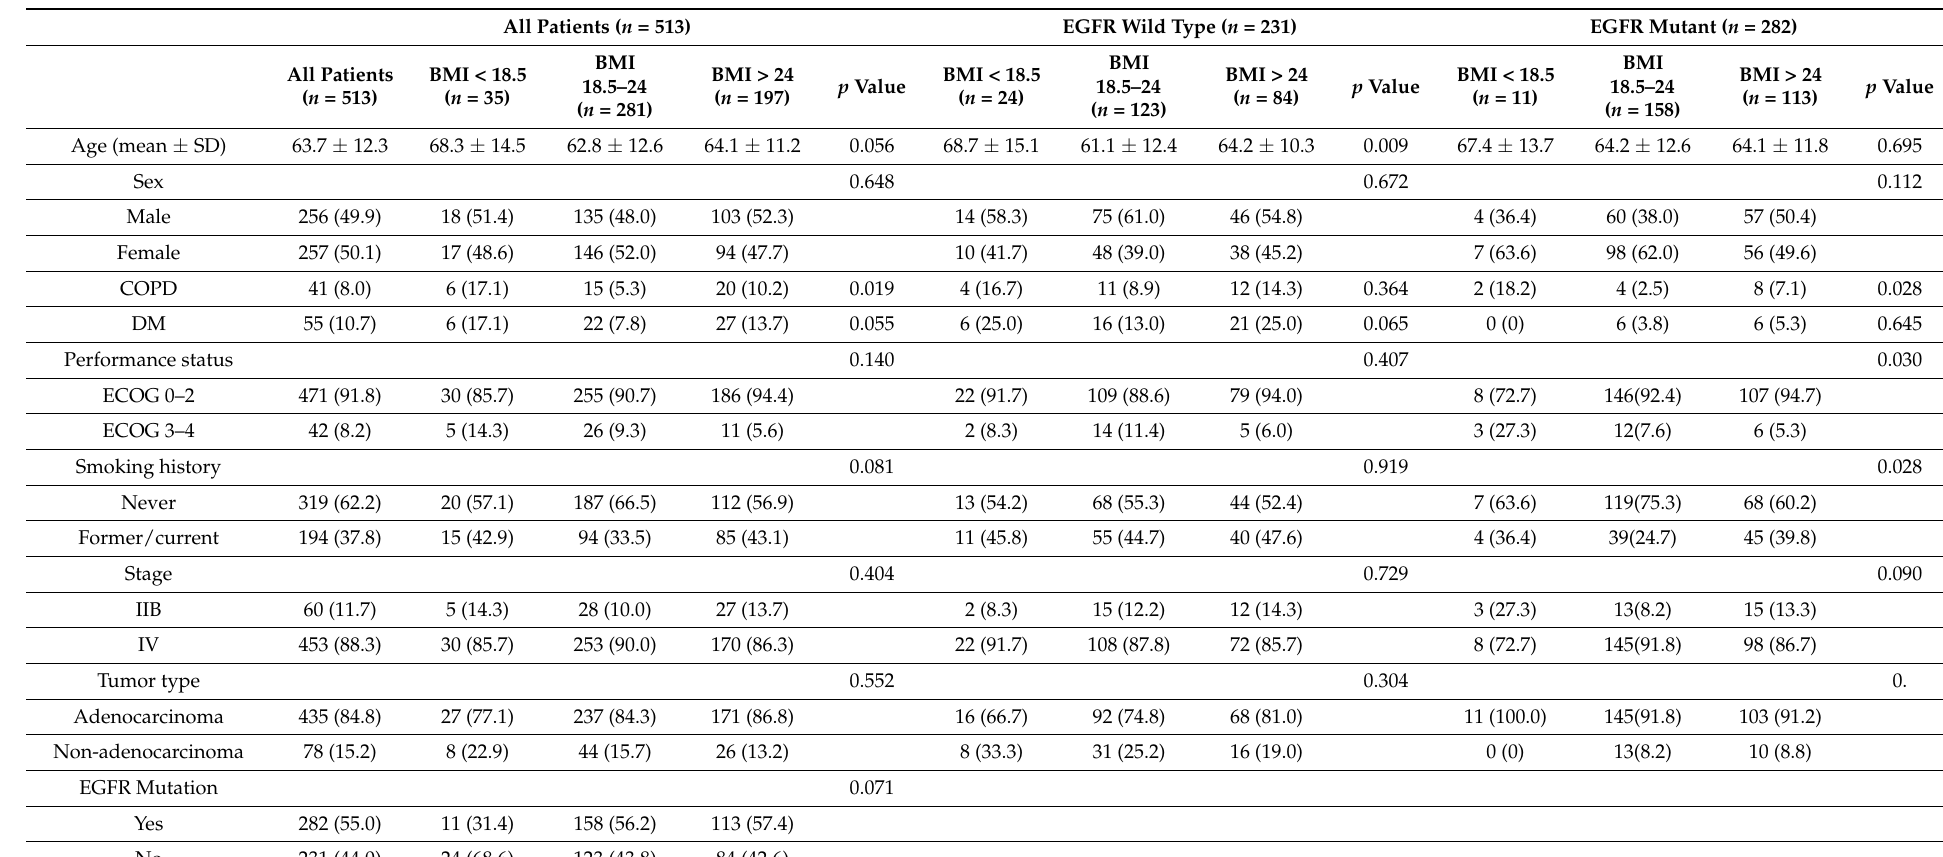
Table 2. Clinical characteristics of underweight, normal weight, and overweight